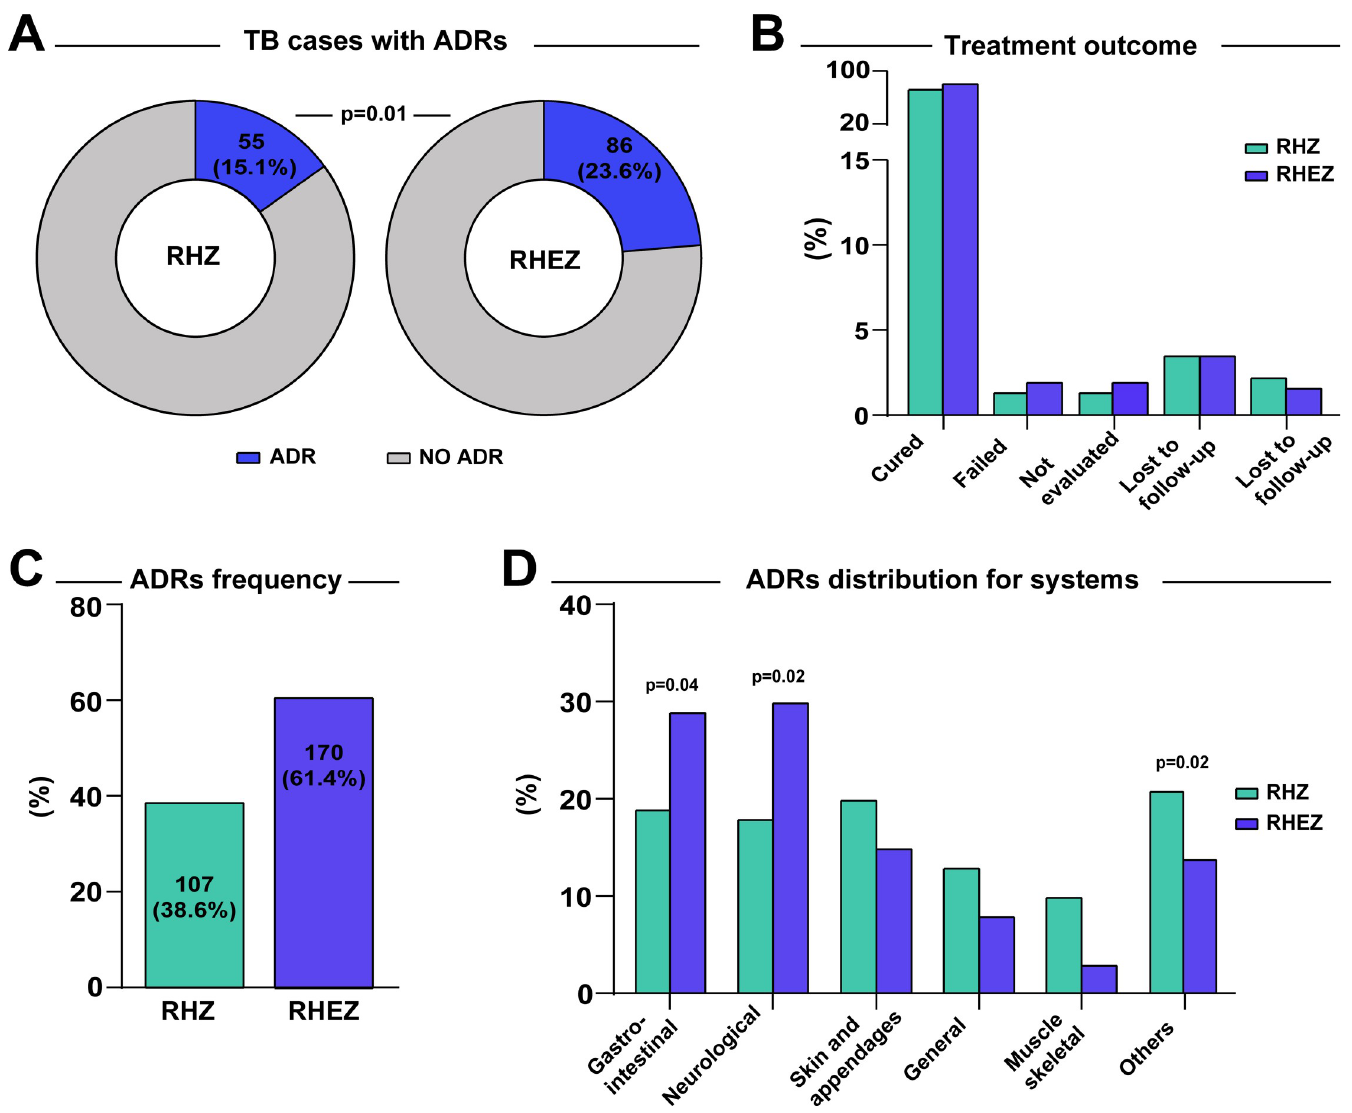
Fig 2. Distribution of ADRs in TB patients. (A) Frequency of ADRs in patients with RHZ and RHEZ anti- TB regime. (B) Outcomes treatment were compared between patients with RHZ and RHEZ anti-TB treatment. The significant p values are shown. (C) ADRs frequencies of anti-TB treatment groups with RHZ and RHEZ are shown. (D) ADRs distribution for systems were compared between patients with RHZ and RHEZ anti-TB treatment. The significant p-values are shown. Others: Hepatic, ocular, circulatory and respiratory system.